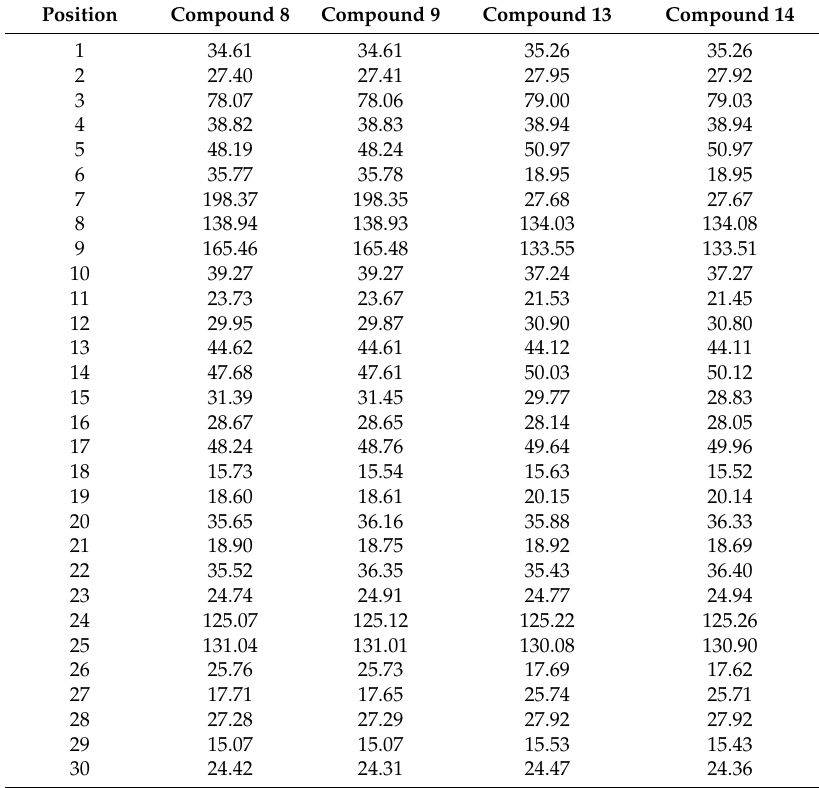
Table 5. 13 C-NMR data of compounds 8 , 9 , 13 and 14